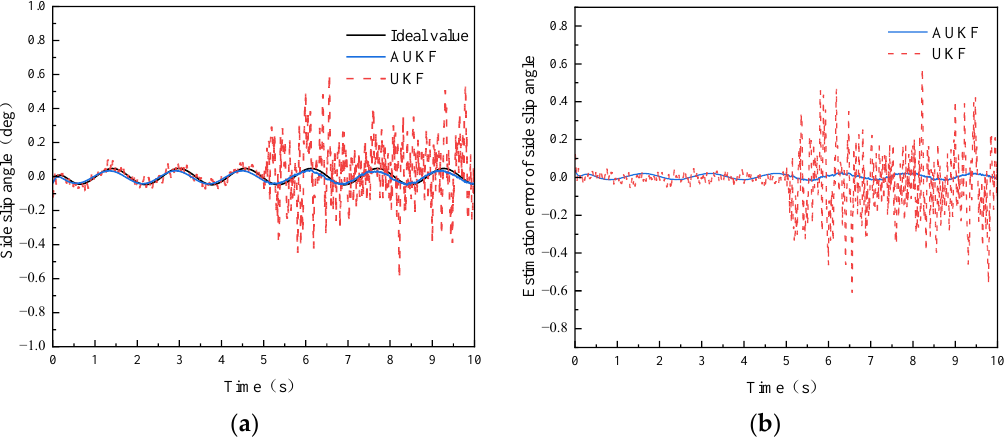
Figure 13. Simulation results of side slip angle. ( a ) Comparison of estimated results and ( b ) comparison of estimated error.